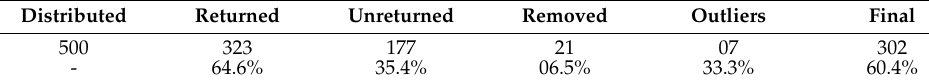
Table 1. Data cleaning, outliers, and response rate.